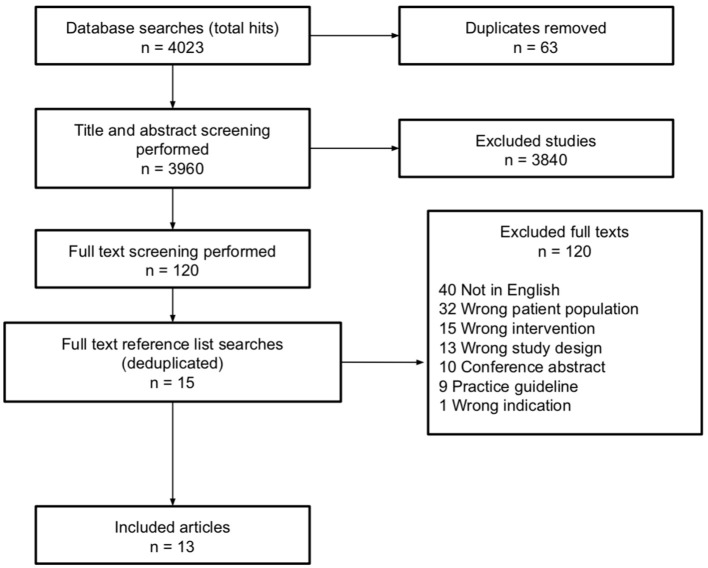
Preferred reporting items systematic reviews and meta-analyses (PRISMA) flow diagram detailing search strategy and selection criteria.